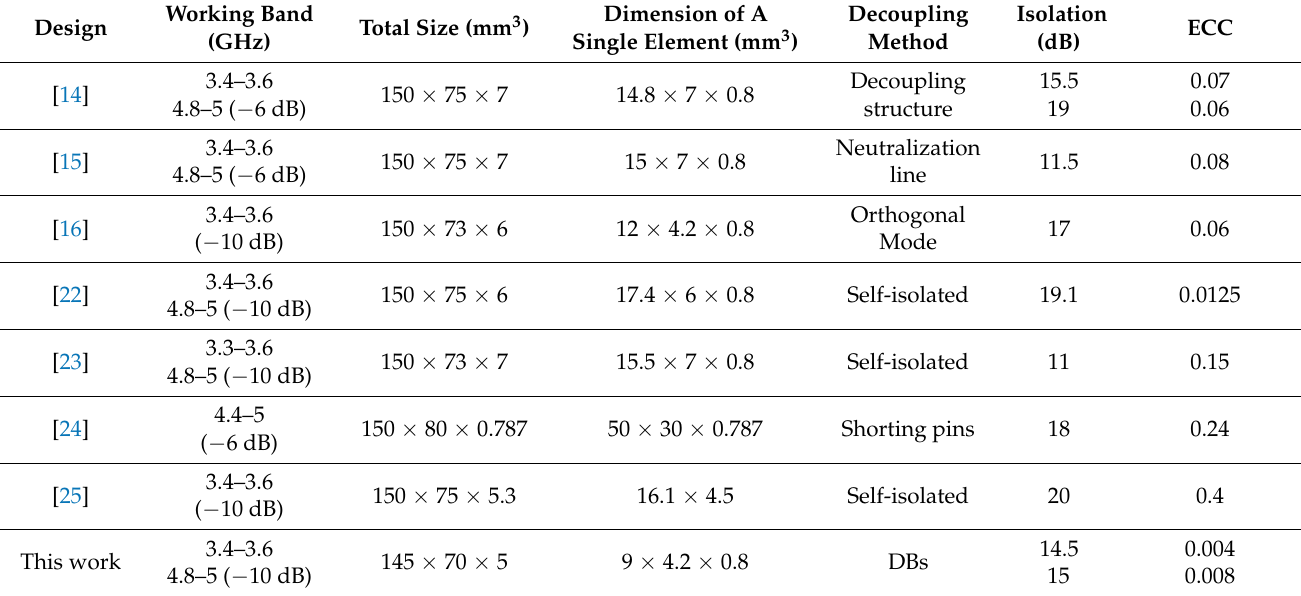
Table 2. Performance contrast between this work and other reported 5G smartphone antennas.